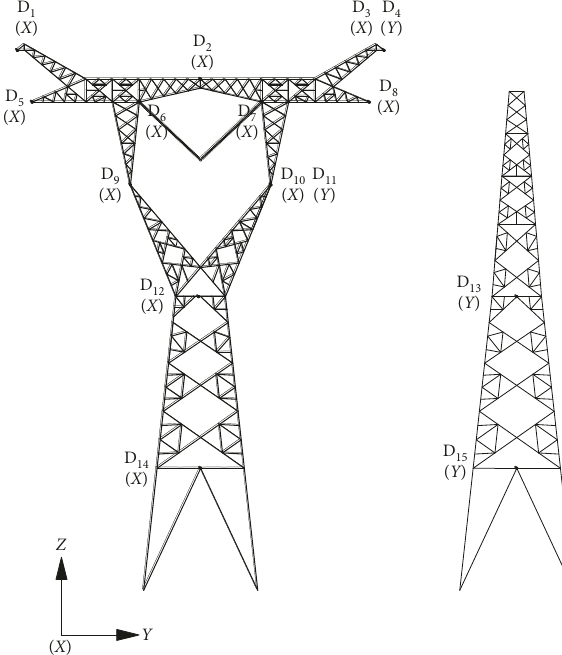
Figure 13: Layout of displacement